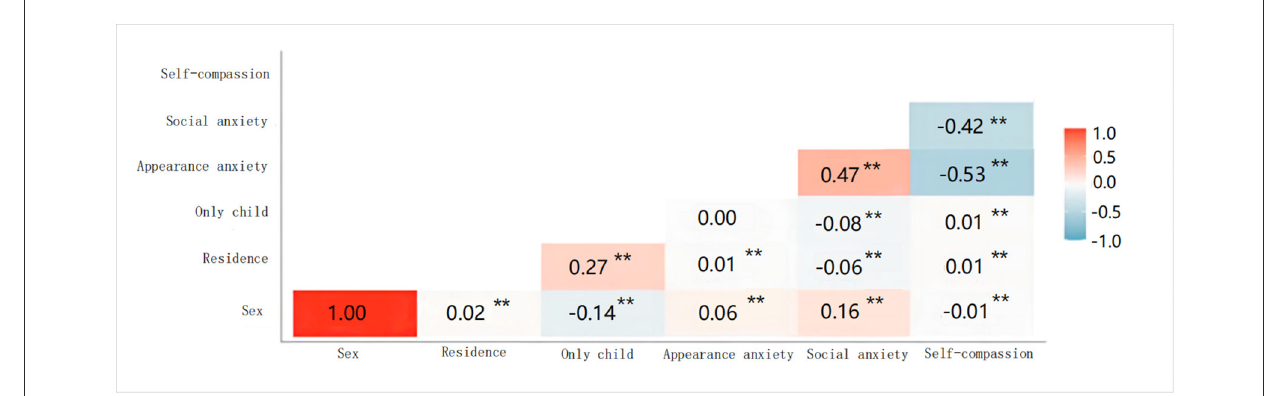
FIGURE1 Pearson correlations of main variances. Sex, only child, and residence are dummy variables. Female = 1, others = 0; only child = 1, others = 0; urban = 1, others = 0. ** p < 0.01.